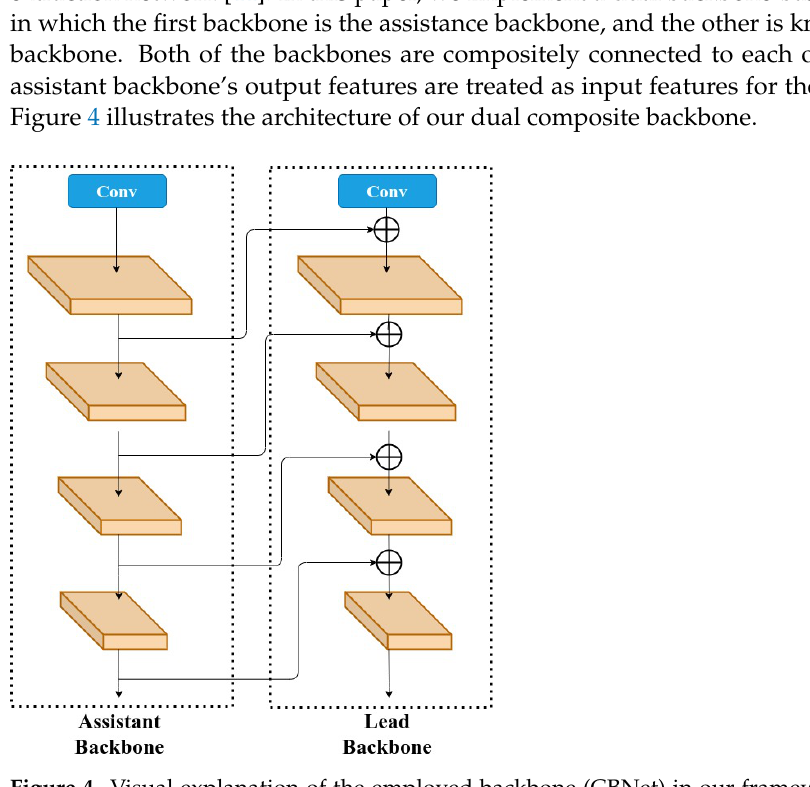
Figure 4. Visual explanation of the employed backbone (CBNet) in our framework. We utilize a dual ResNeXt-101 backbone, in which there are composite connections between parallel stages of the adjacent assistant and lead backbone. Moreover, we replace the conventional convolutions in ResNeXt101 with deformable